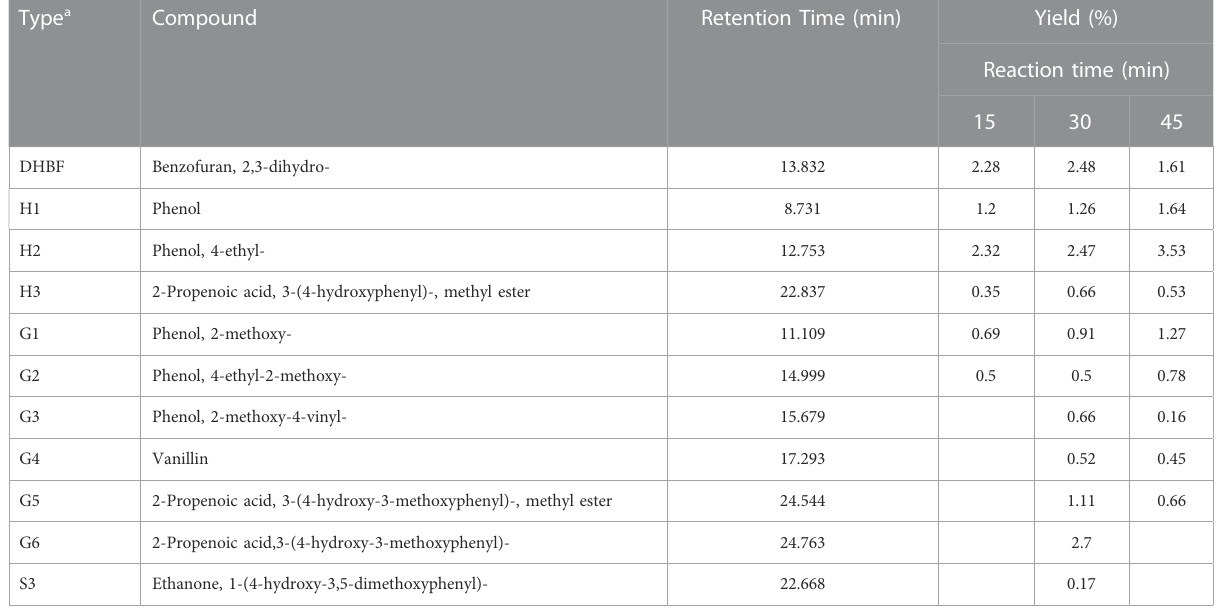
TABLE 5 Effect of reaction time on the distribution of lignin-derived aromatic monomers. Type